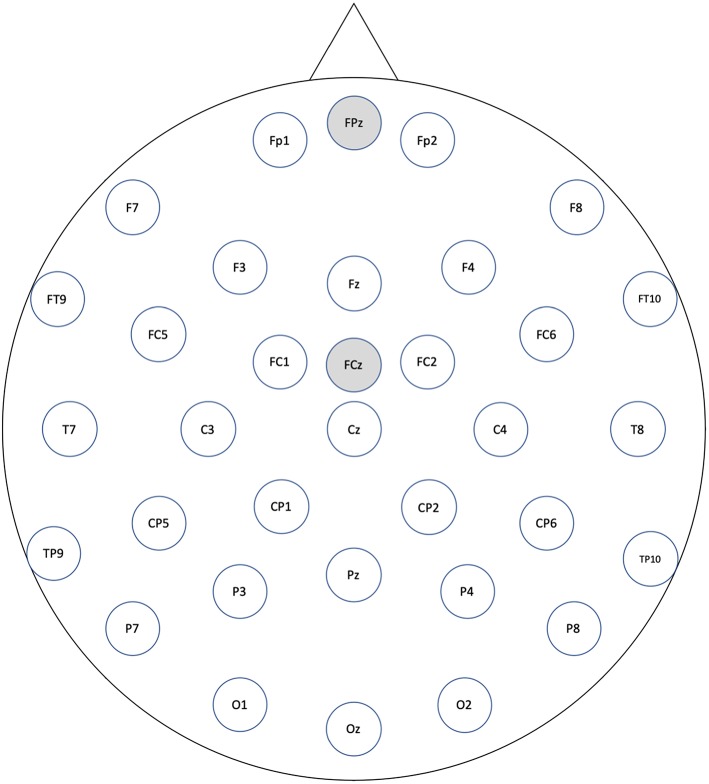
All electrode labels: gray electrodes indicate reference and grand position.